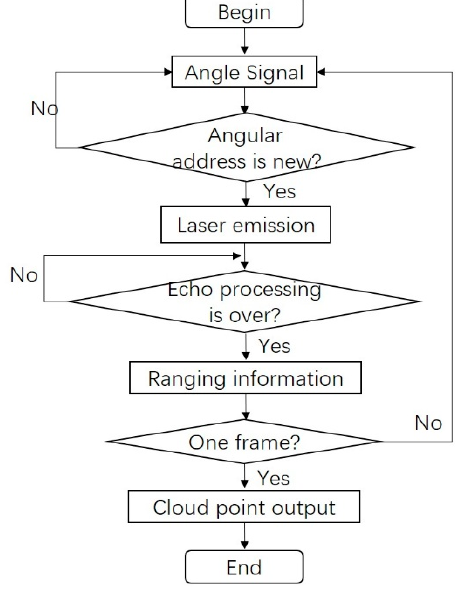
Figure 3. Procedure of reconfigurable angular resolution design method.